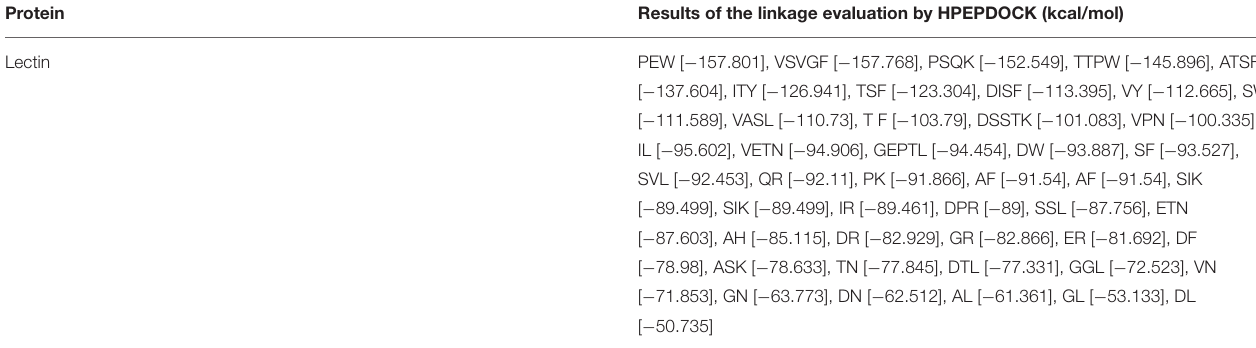
TABLE 8 | Ligand-receptor affinity scores obtained with HPEPDOCK SERVER (kcal/mol).